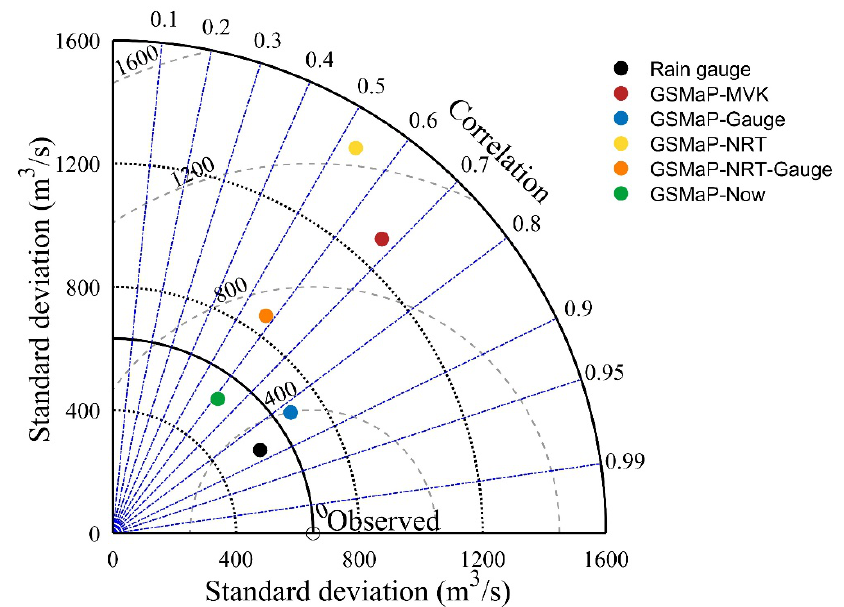
Figure 14. Taylor diagrams showing the overall performance of hourly simulations of the four flood events in 2017 and 2018 at the Tangnaihai hydrological station using the rain-gauge-based precipitation data set and the five GSMaP SPPs based on the observed discharge data.